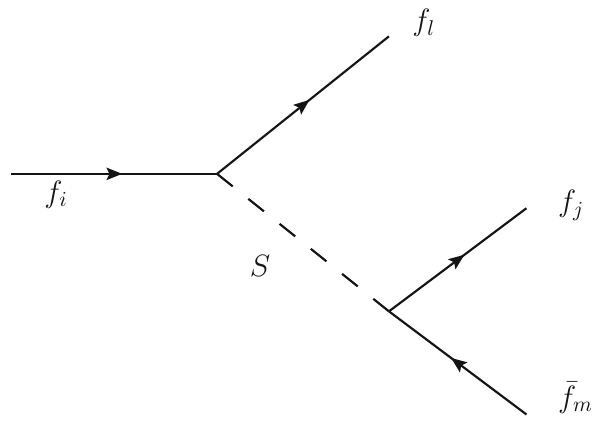
Fig. 4 Feynman diagram for the tree-level FCNC decay f i → f j ¯ f m f l induced by a scalar LQ. Here f l and f m are leptons (quarks) if f i and f j are quarks